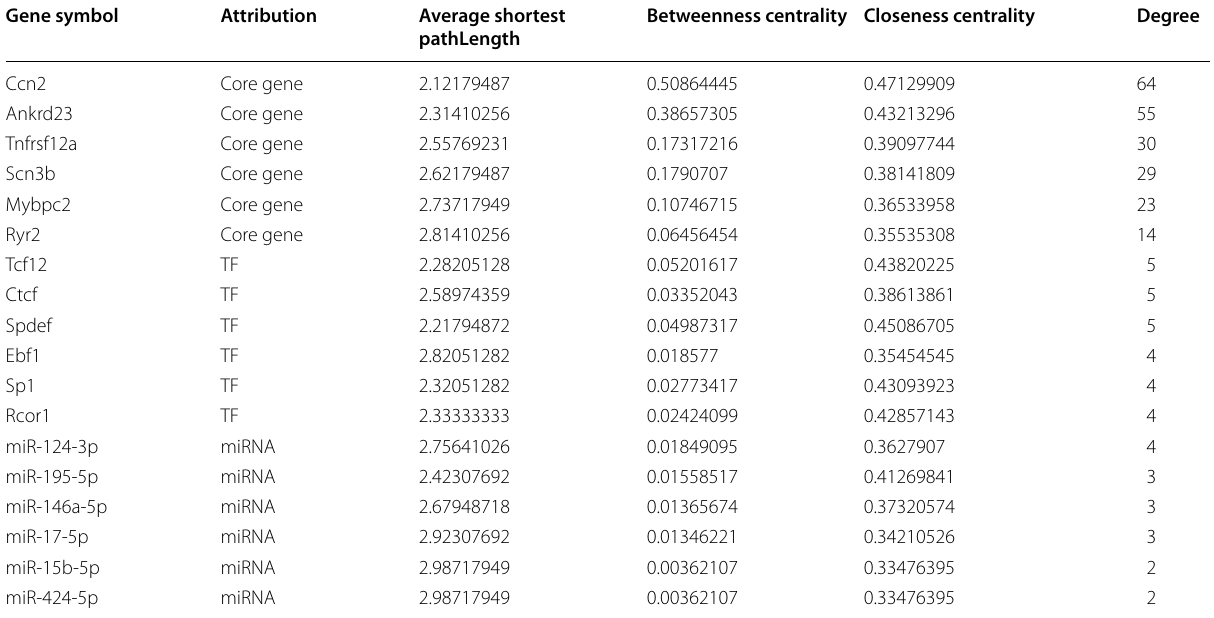
Table 2 Topological parameters of key